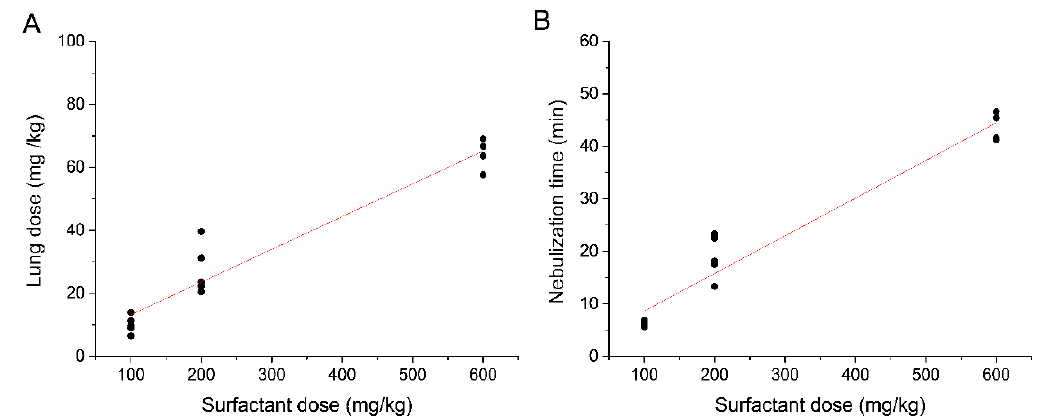
Figure 4. ( A ) Linear regression analysis between the lung dose and the nominal surfactant dose (r 2 = 0.9256) and ( B ) between the nebulization time and the nominal surfactant dose (r 2 = 0.9427).